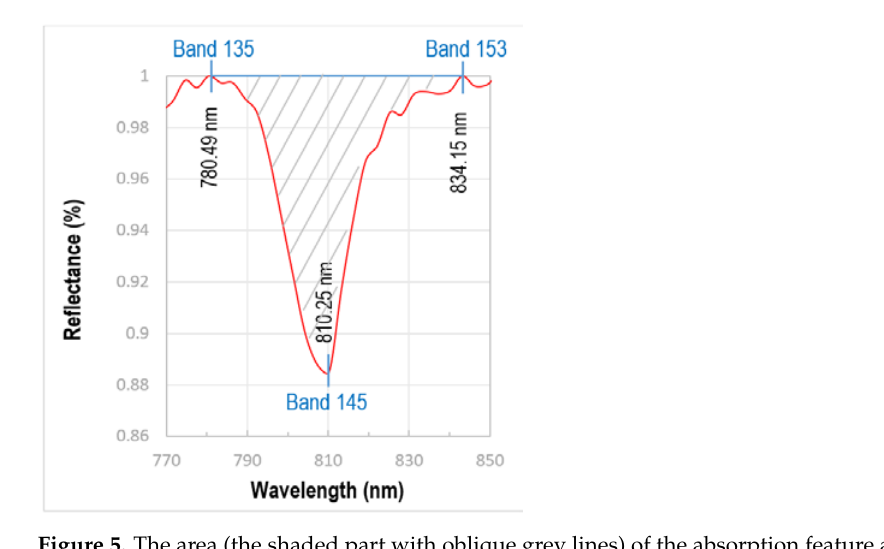
Figure 5. The area (the shaded part with oblique grey lines) of the absorption feature at wavelength 810.25 nm corresponds to the Nd concentration. The wavelengths 780.49 nm (band 135) and 834.15 nm (band 145) are taken as the shoulders of the Nd absorption feature.